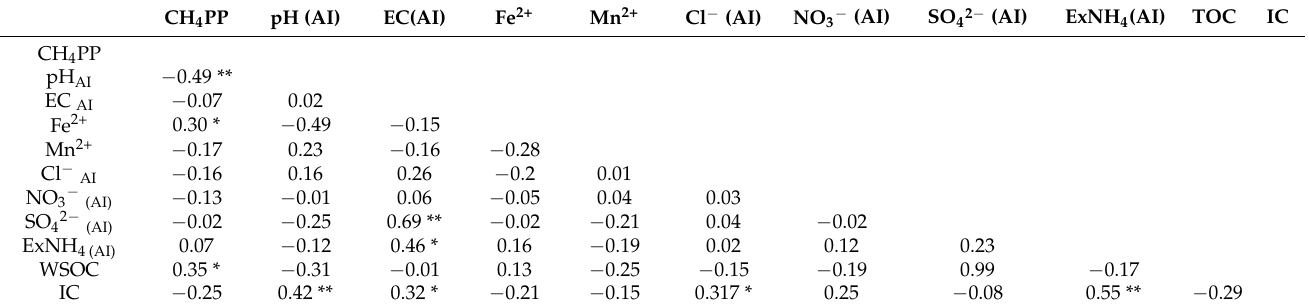
Table 2. Correlation matrix among CH 4 Production Potential (CH 4 PP) and soil properties (after incubation).